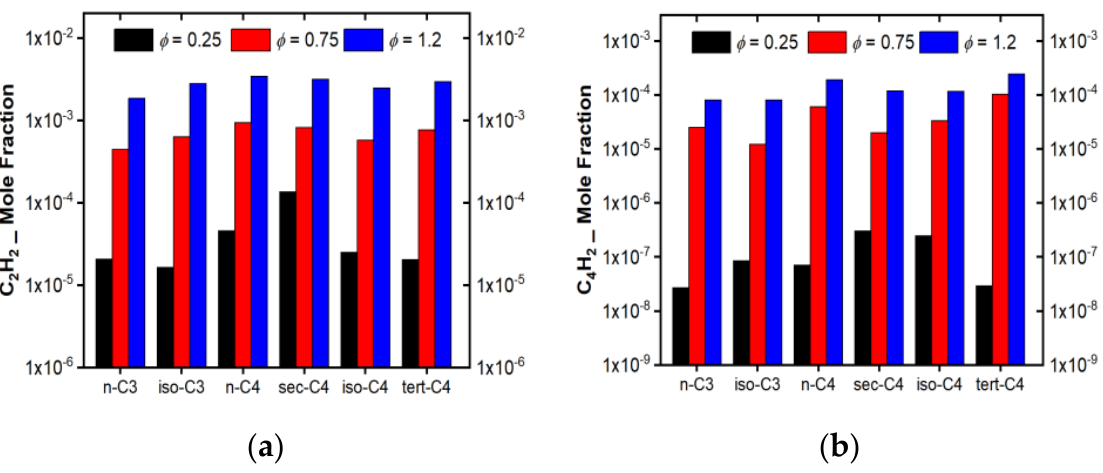
Figure 17. Model prediction for the peak value of ( a ) C 2 H 2 , and ( b ) C 4 H 2 mole fraction a free flame at 860 K and 36 atm for the unburned fuel/air-mixture.